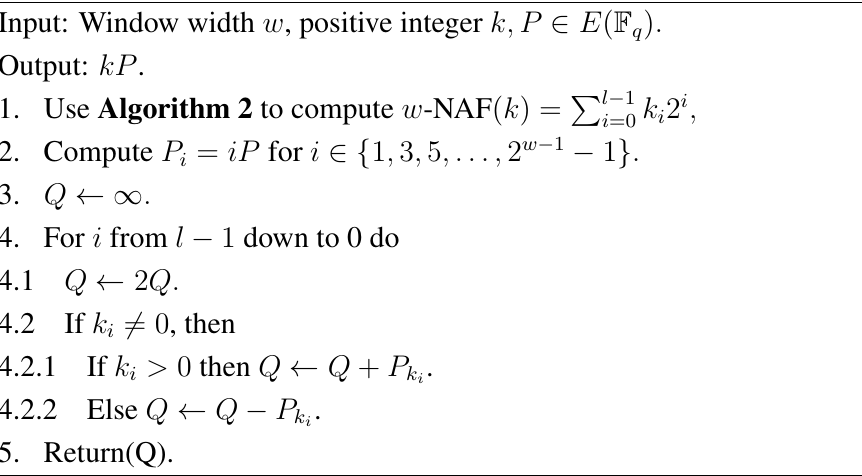
Algorithm 3. Window NAF method for point